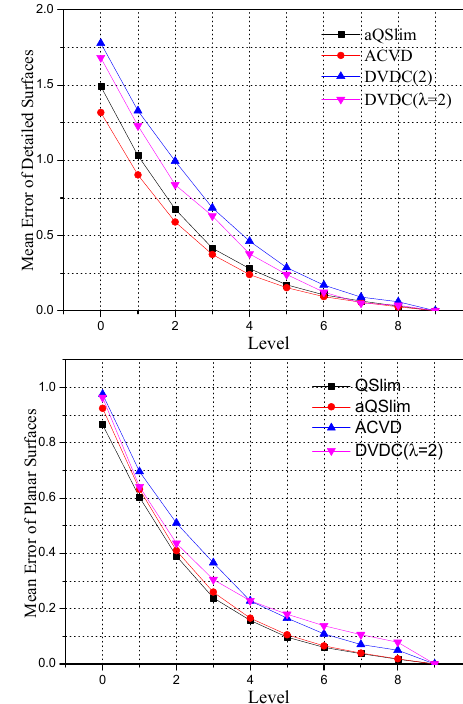
λ= ) still perform